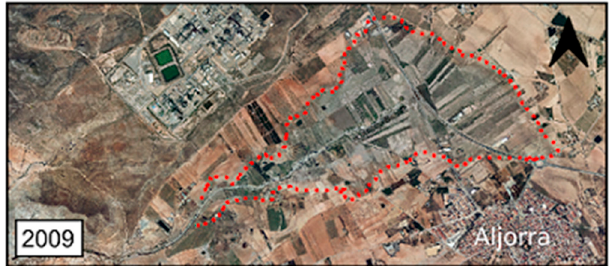
Figure 12. Sedimentary record. The dashed red line delimits the maximum range of sediments coming from the Pericón mountain range.